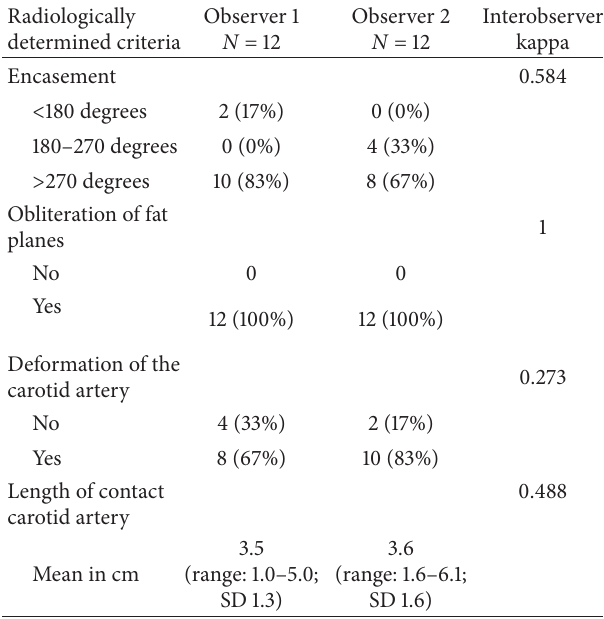
Table 1: Radiologically determined criteria and interobserver